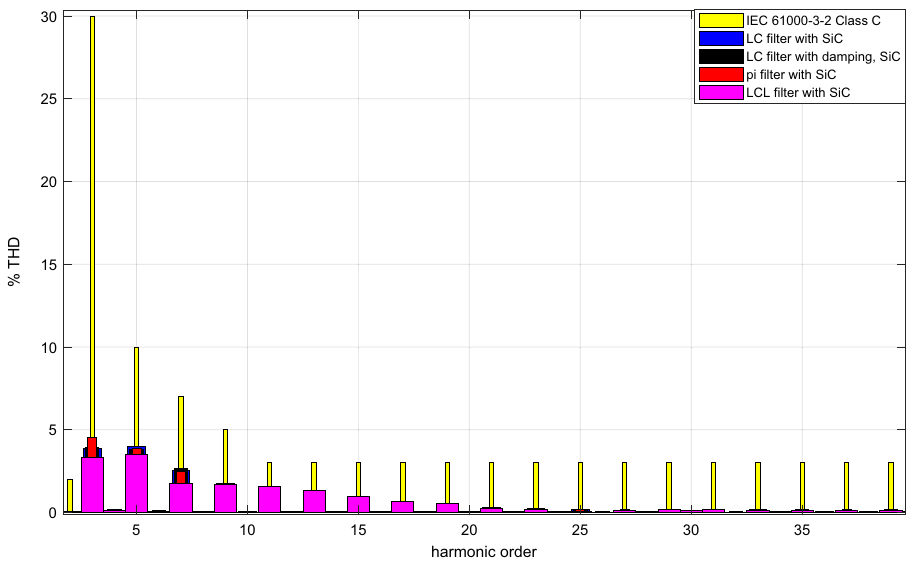
Figure 36. Grid current THD comparison with SiC Mosfet.